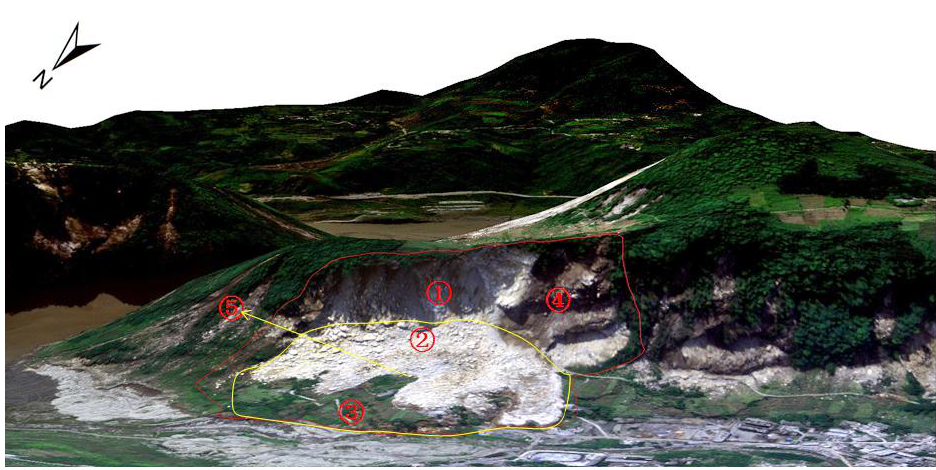
Figure 4. 3D image of the case-study site. The tested landslide is enclosed by the red line. This image provides clear figures of the main scarp ① ; the head ② ; the toe ③ ; the minor scarp ④ ; and the main body ⑤ (Enclosed by the yellow